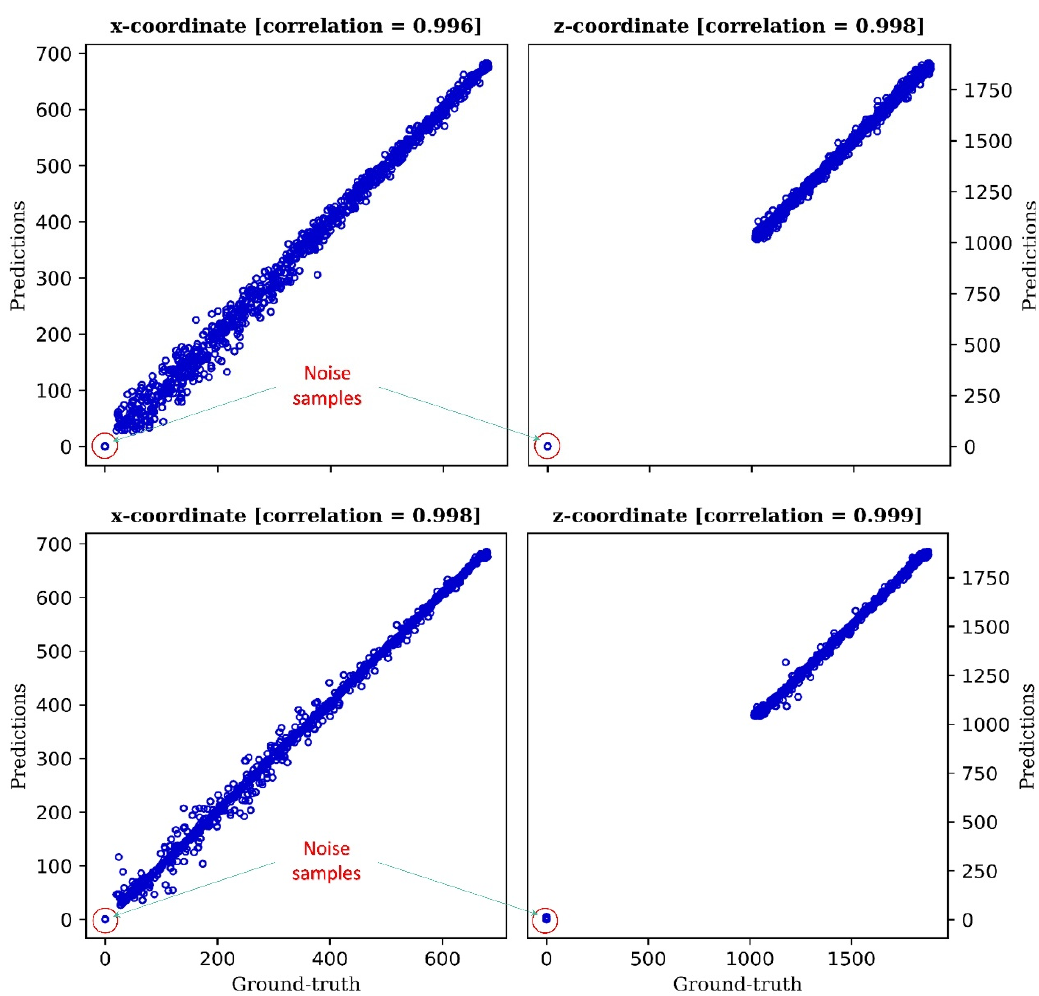
Figure 9. The correlation plot of the predicted versus ground-truth events. The dots at the origin of both plots are the noise samples. The wide gap in the right plot is because the minimum depth of the microseismic events was 1050 m. Top row: Inception-ResNet output. Bottom row: ResNet output. Pearson correlation coefficient is indicated in the subtitle of each plot. The same correlation plots are shown in Figure 10 after the removal of noise samples from the plots.